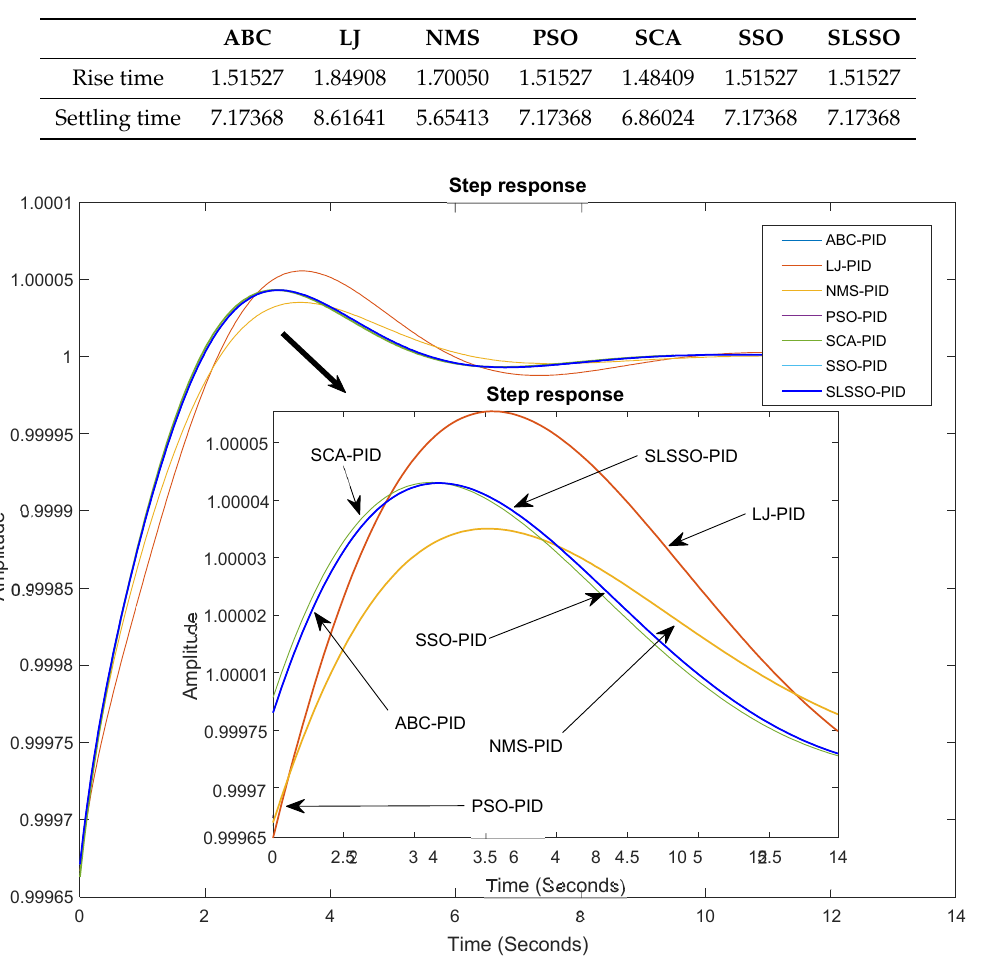
Figure 8. Unit step response for control loop